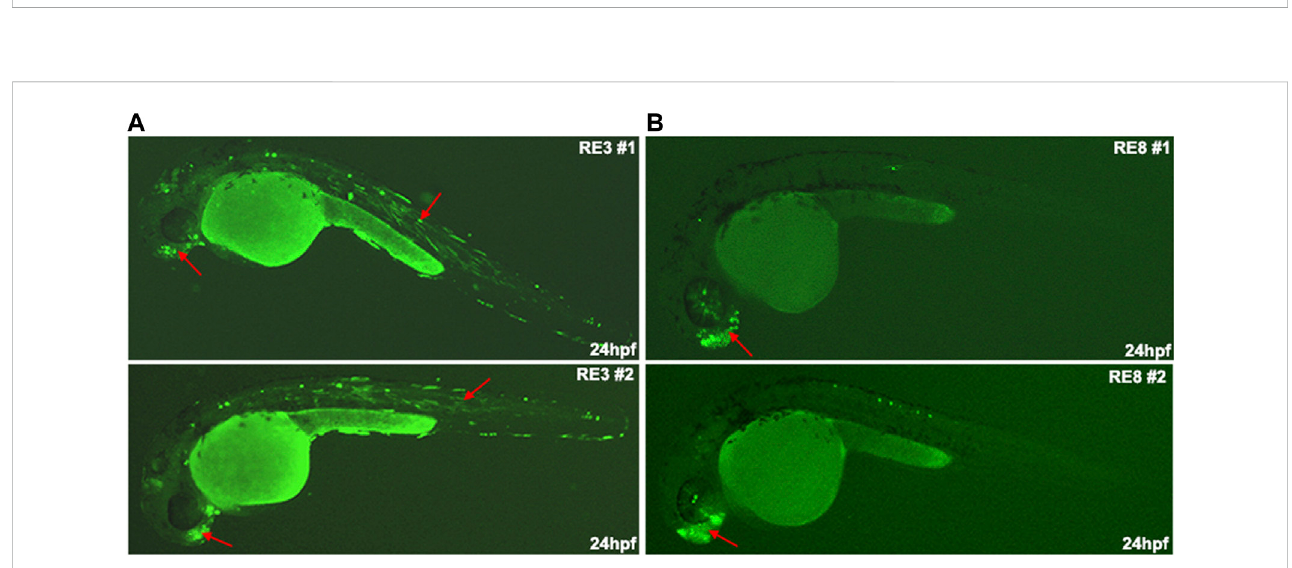
FIGURE 4 The in vivo activity of regulatory elements marked as active enhancers at 24/48 hpf zebra fi sh embryos. (A) ZEB2e2 drove GFP expression in the notochord. (B) ZEB2e3droveGFPexpressioninthemidbrain,hindbrain,spinalcord,andsomiticmuscles. (C) ZEB2e4droveGFPexpressioninnotochordand non-speci fi c neurons. (D) MEF2Ce7 drove GFP expression in the notochord. (E) MEF2Ce9 drove GFP expression in the midbrain, hindbrain, and spinal cord. The pattern of each enhancer is represented by images of two independent transgenic zebra fi sh embryos.